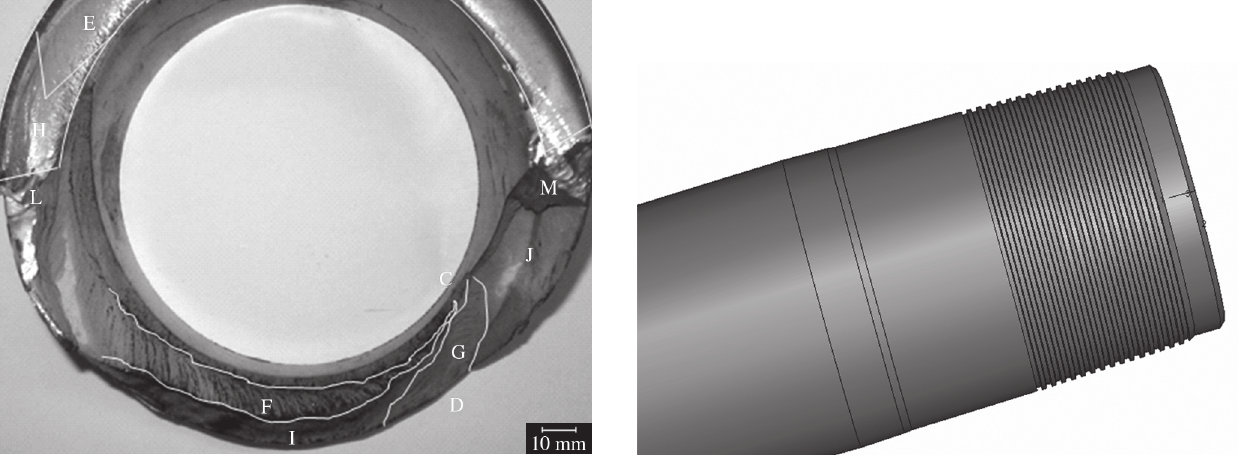
Figure 14. Threaded surface of the aluminum drill